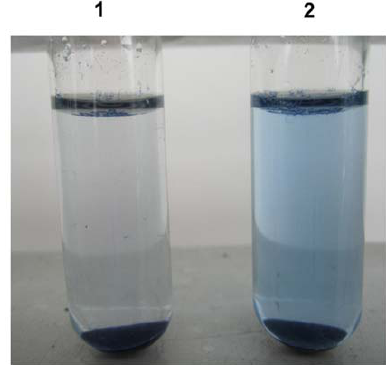
Figure 7. The keratin azure degradation by recombinant keratinase at 50 u C after 1 h (1, control without keratinase; 2, keratinase